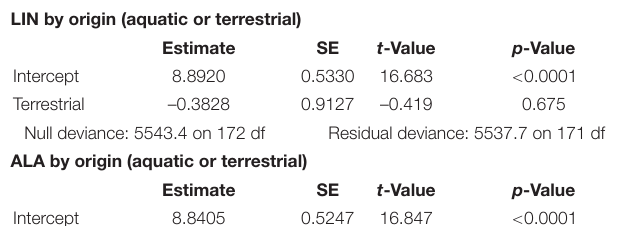
were conducted in R, version 4.0.3 and all figures were created in R using ggplot2 (Wickham, 2011).